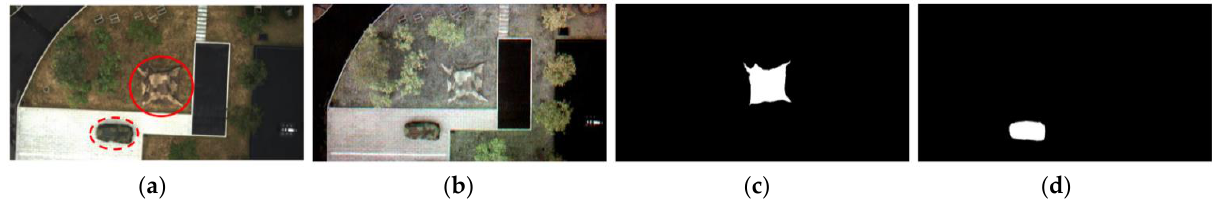
Figure 19. The quantitative comparison of ASRC-net detection results in the BF scene at 16 mm focal length; ( a ) The curves of A C using different methods; ( b ) The curves of F a using different methods; ( c ) The histograms of F 1 using different methods.